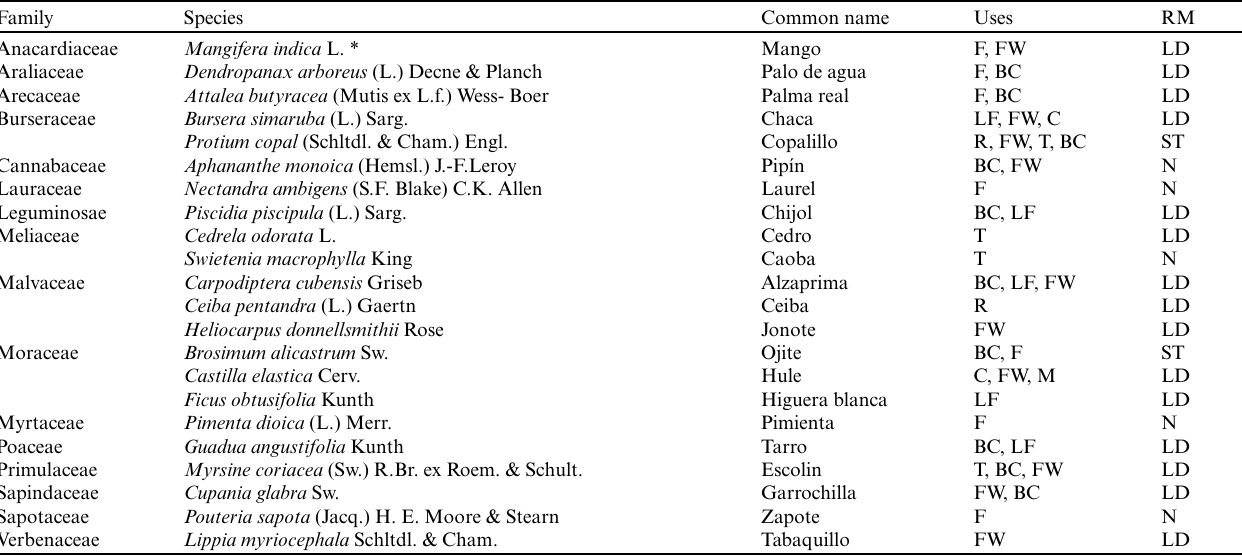
Table 3 . Species designed for the integration of agro-ecosystems (vanilla production) associated with Zuelania guidonia . Uses: BC: building construction, C: crafts and tools, F: food, FW: fuelwood, LF: live fencing, M: medicinal, R: ritual and ornamental, and T: timber. Regeneration mode (RM): shade-tolerant (ST), light-demanding (LD), and nomads (N). * exotic